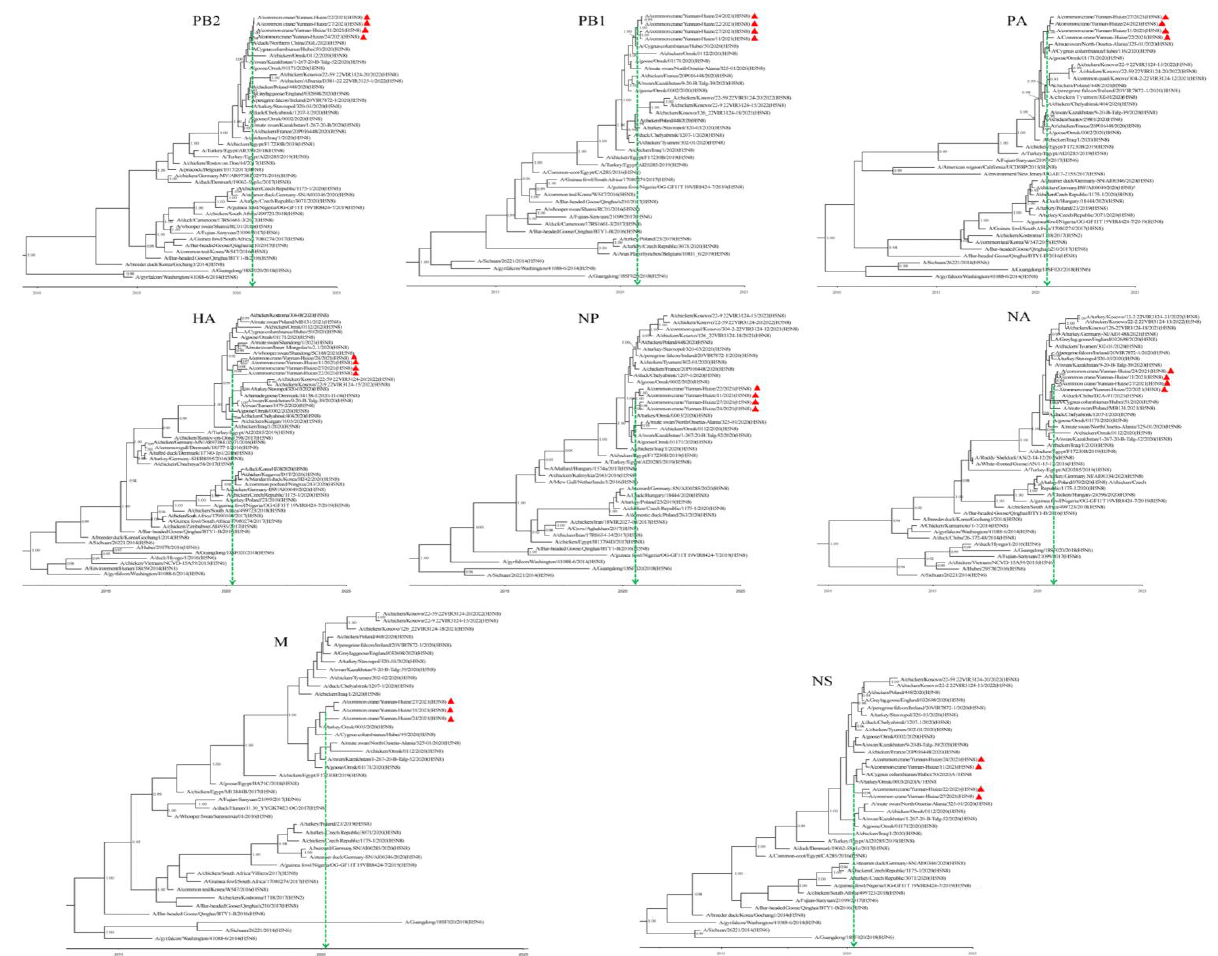
Figure 3. The time-scaled maximum clade credibility (MCC) trees of the eight gene segments of the H5N8 AIVs were constructed using BEAST version 1.10.4. The green dotted vertical lines point indicate the mean time of the most recent common ancestor (tMRCA) of each gene segment. Strains identified in this study are labelled with red triangles. The branch supports are indicated by the Bayesian posterior probabilities and values higher than 0.90 are shown in branch nodes. Table 1. The mean time of the most recent common ancestor (tMRCA) for the eight genetic segments of H5N8 AIV from common cranes wintering in Yunnan Province, China, in 2021. Gene Segment 1 Mean tMRCA 95% HPD (Highest Posterior Density) Posterior Probability PB2